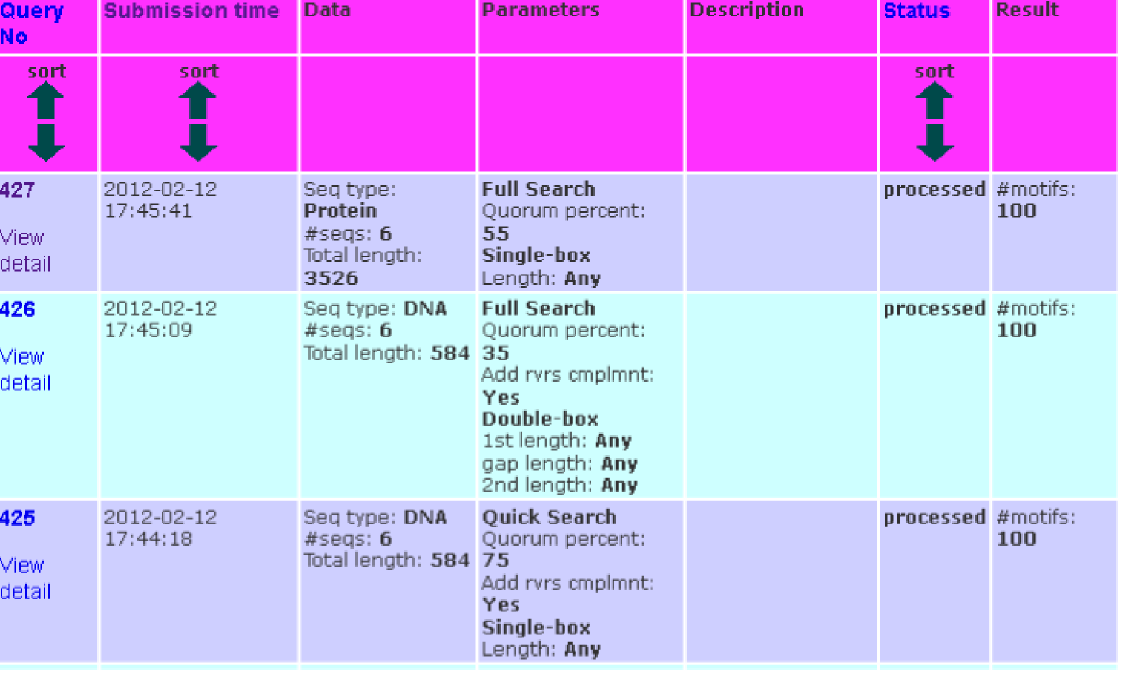
Algorithm PMS5 can be thought of as an extension of PMS0